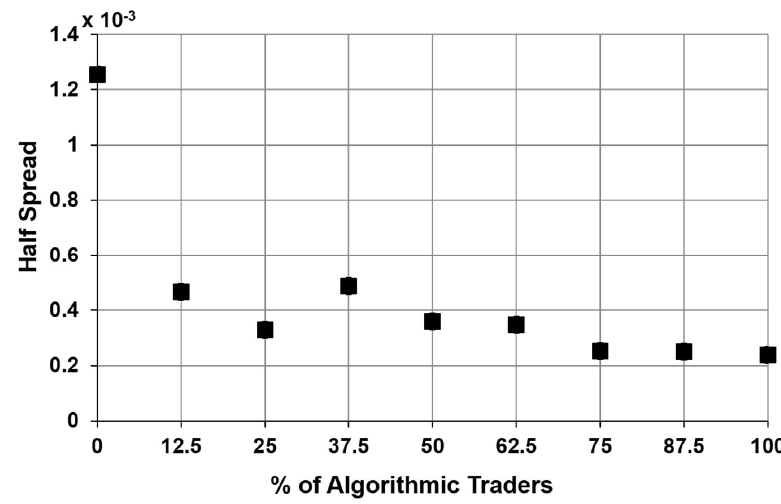
Figure 1. Impact of AT on market liquidity measured by the half-spread.